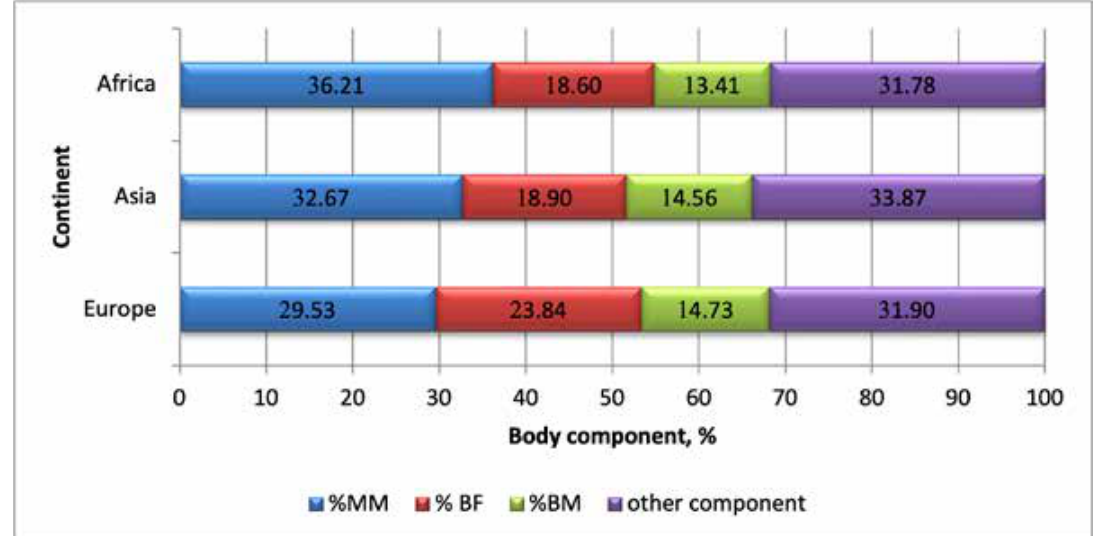
Figure 4. The ratio between the body components of students of different races: %BF - percentage body fat; %MM - percentage muscle mass; %BM - percentage bone